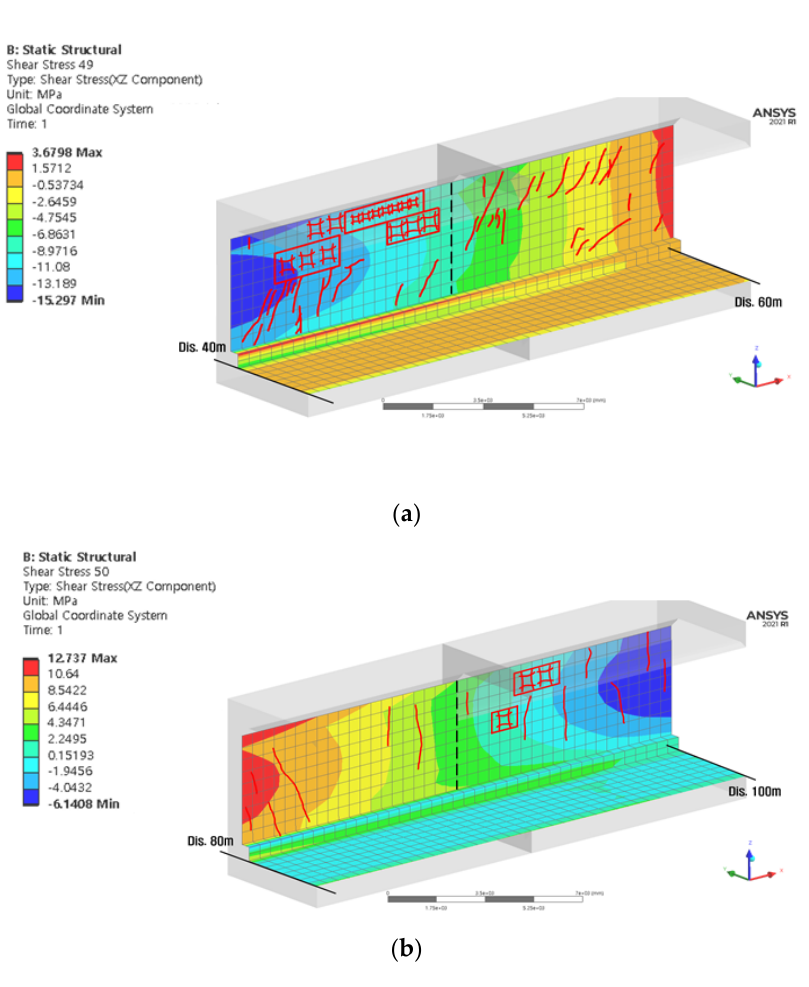
Figure 10. Comparison between the visual inspection mesh diagram and analysis results (Cell 1 wall) for the transition section: ( a ) 40–60 m; ( b ) 80–100 m.